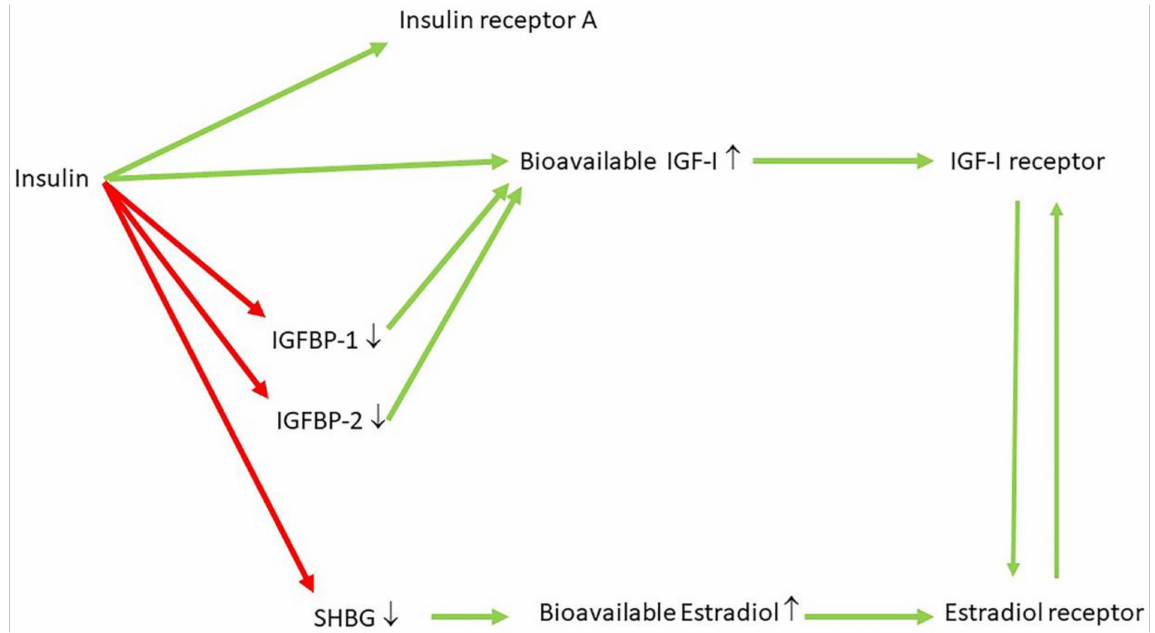
Figure 5. Interactions between insulin, IGFBP-1, IGFBP-2, SHBG, IGF-I bioavailability, the insulin receptor-A, the IGF-I receptor, estradiol and the estradiol receptor. Inhibitory effects are shown in red and stimulatory effects in green. Insulin stimulates the insulin receptor A (directly) and increases bioavailable IGF-I and estradiol (indirectly). Note that there is also bidirectional cross-talk between the IGF-I receptor and the estradiol receptor. IGFBP-1 = insulin-like growth factor binding protein-1, IGFBP-2 = insulin-like growth factor binding protein-2, SHBG= sex hormone binding globulin, ↑ levels increase, ↓ levels